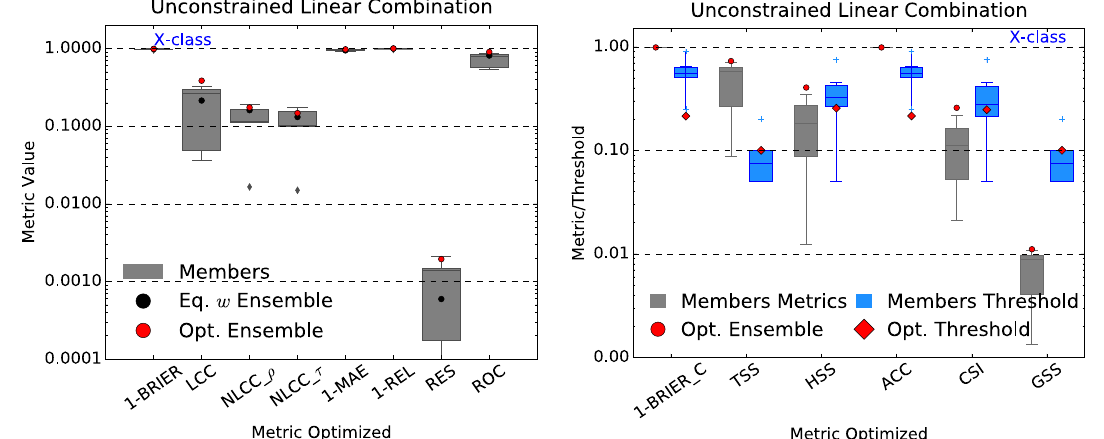
Fig. C.3. Same as Figure 5, but for X-class fl are forecasts.